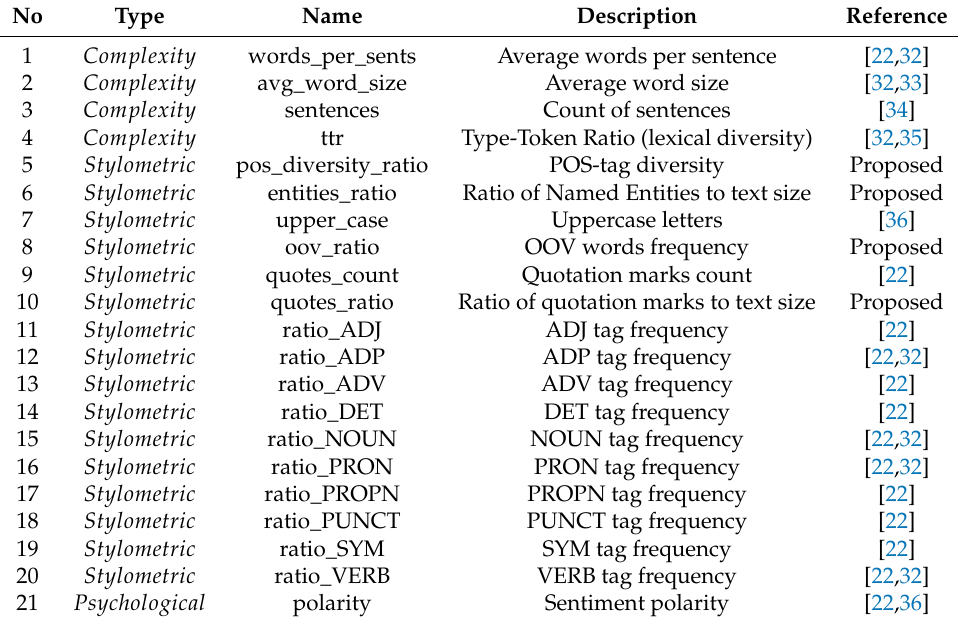
Table 1. List of extracted features. There are three types of features: Complexity, Stylometric, and Psychological. POS = part of speech; OOV = Out-Of-Vocabulary, ADJ = Adjectives, ADP = Adposition, ADV = Adverbs, DET = Determiner, NOUN = Noun, PRON = Pronoun, PROPN = Personal Pronouns, PUNCT = Punctuation, SYM = Synonyms and VERB = Verb. No Type